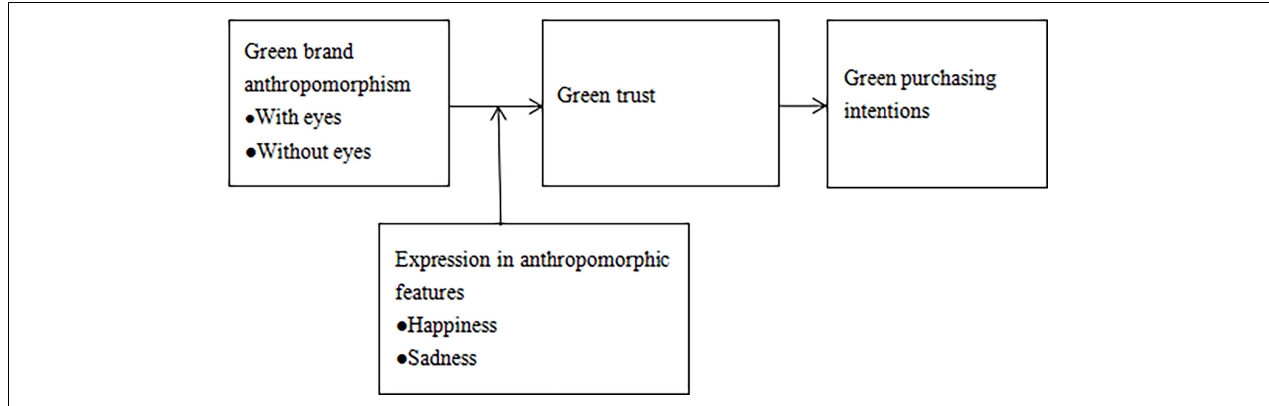
FIGURE 1 | Research